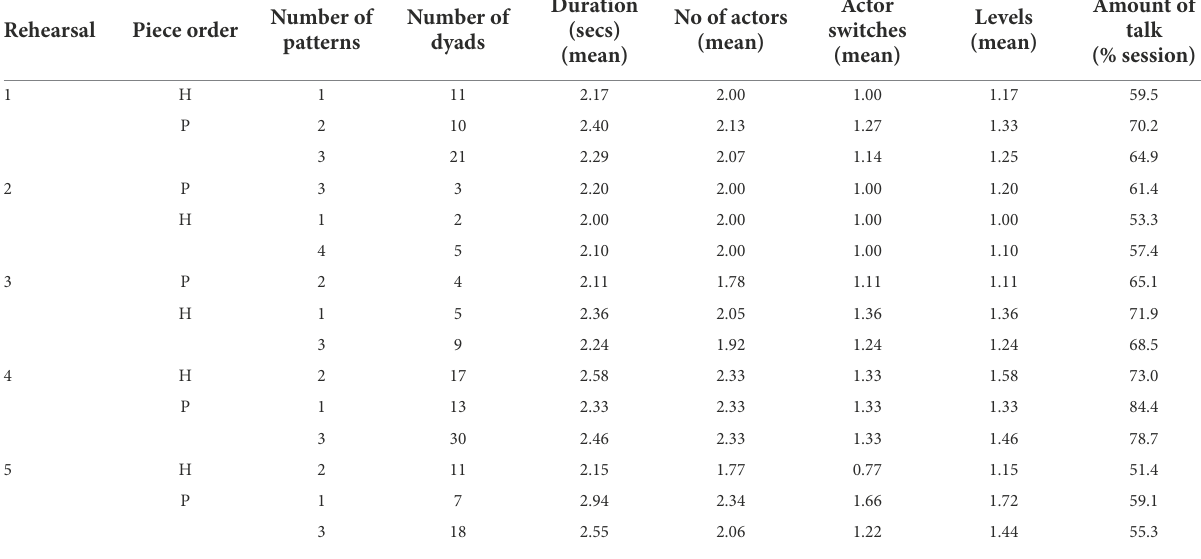
TABLE 6 Summary of main patterns by rehearsal and piece; number of main patterns, number of dyads, number of actors, duration and actor switches, and talk time as % of session